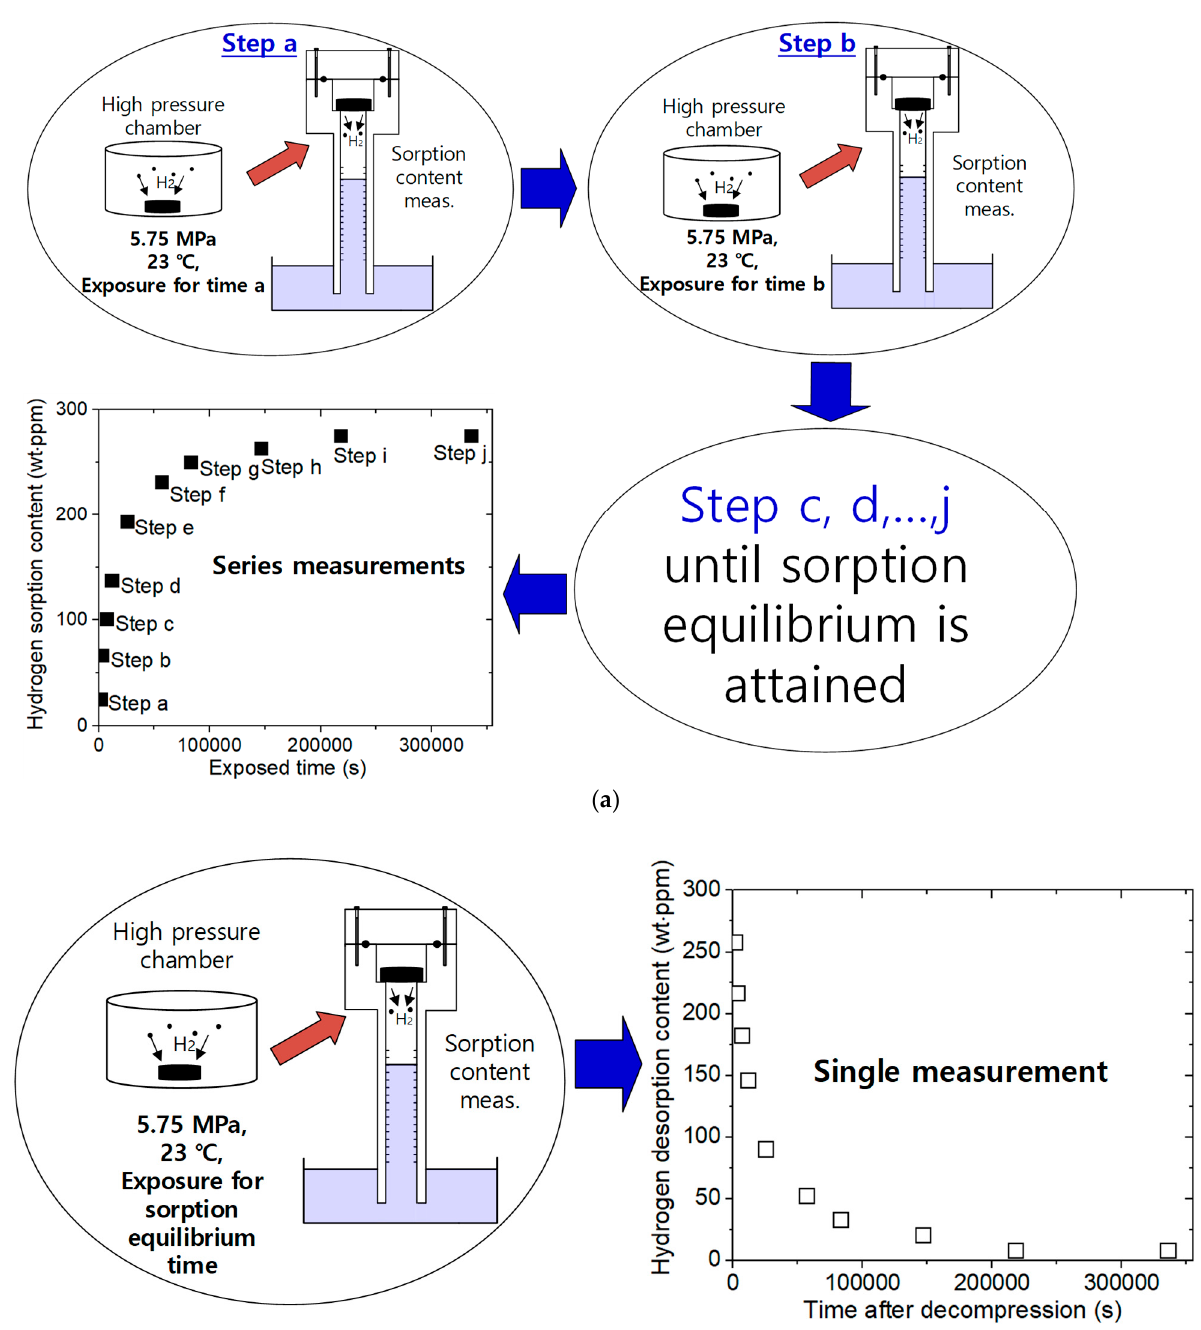
Figure 2. ( a ) Clockwise sequence for measuring the diffusion parameter in the sorption process. The measurement was performed by VAT after loading the rubber exposed to a high-pressure chamber inside the graduated cylinder. The sorption contents were measured as a function of the residence time (exposed time, a, b, . . . , j) of the specimen in the high-pressure chamber. This array of measurements corresponded to a series measurement. ( b ) Sequence for measuring the diffusion parameter in the desorption process. The measurement was performed by VAT after loading the rubber exposed to a high-pressure chamber inside the graduated cylinder. The desorption contents were determined by a single measurement after the exposure of the specimen for equilibrium